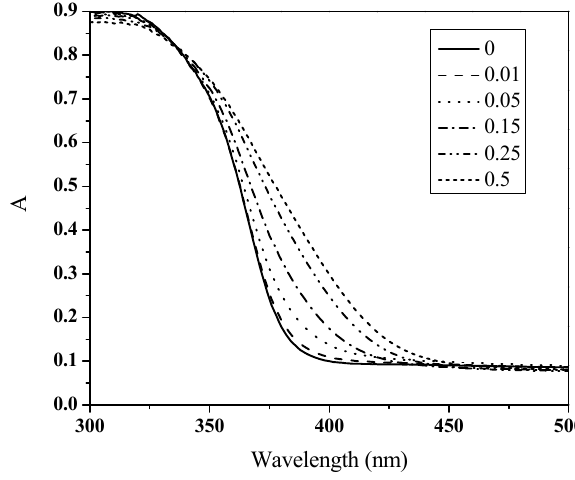
Figure 6. UV-Vis DRS of all the prepared samples.